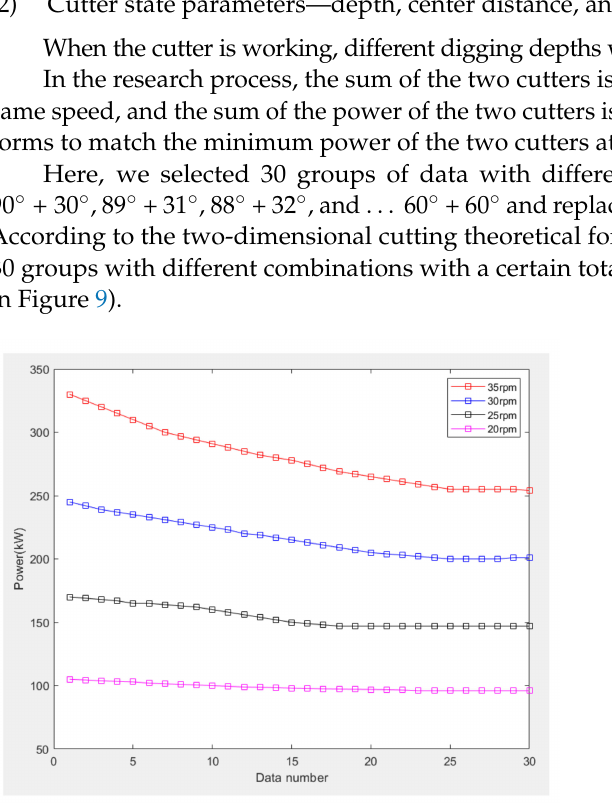
Figure 9. Power diagram showing 30 different